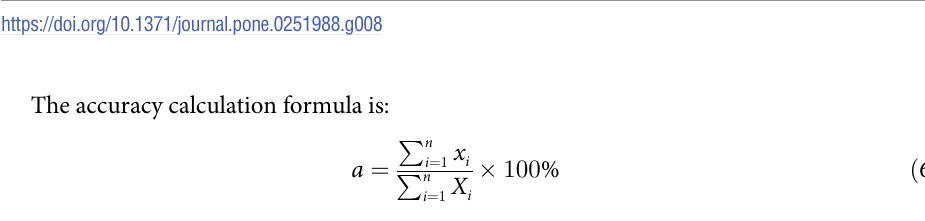
Fig 8. Sampling inspection of urban functional areas in central city area of